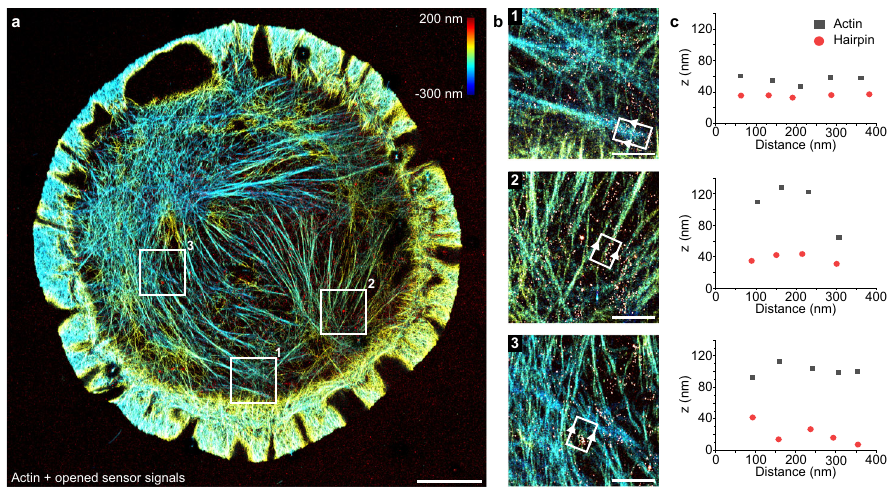
Fig. 4 Two-target 3D super-resolution characterization of hairpin sensors and actin cytoskeleton. a Super-resolved actin network using Lifeact-Cy3B (color-coded according to z-position) overlayed with extended sensor signal (red). b Zoom-ins of highlighted areas in a . c Z-separation between extended hairpin sensor positions and the actin fi laments indicates that the fi laments can be found above the hairpin at various distances. Top: Extended sensor is approximately 20 nm apart from the fi laments. Middle: Mean fi lament position is approximately 80 nm above the extended sensor. Bottom: Mean fi lament position is again 60 – 80 nm above the extended sensor. Scale bars: 5 µ m ( a ), 1 µ m ( b